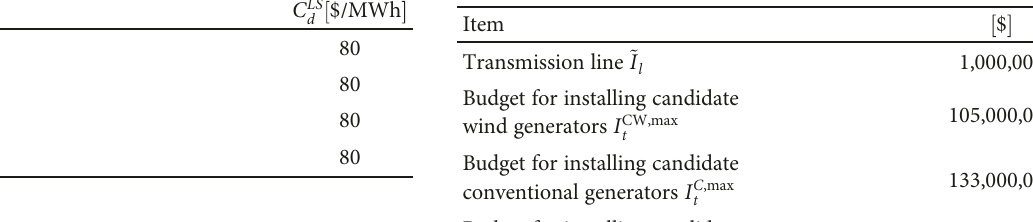
Table 13: Investment costs.